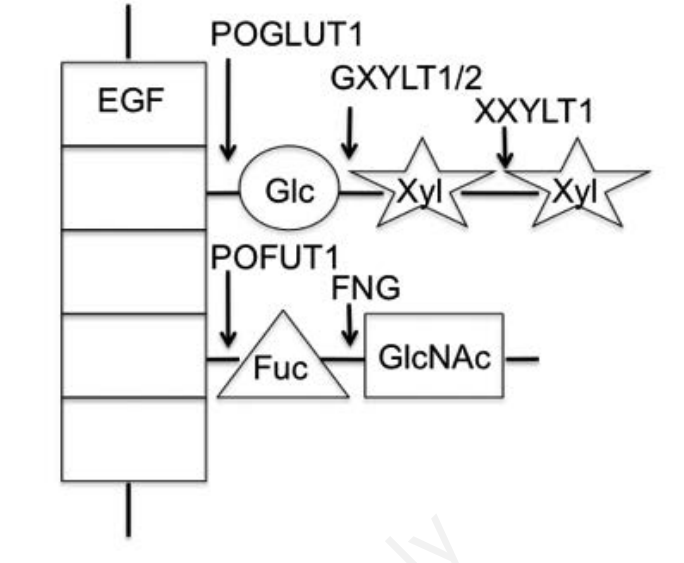
Figure 1. Schematic representation of NOTCH receptor glycosylation. Graphic depiction of the NOTCH extracellular domain, which encodes tandem EGF-like repeats containing the consensus sequences for modification with O -Fuc and O -Glc by POFUT1 and POG- LUT1, respectively. Subsequently, GlcNAc is added to Fuc by FNG, while two Xyl are added to Glc by GXYLT1 /2 and XXYLT1.